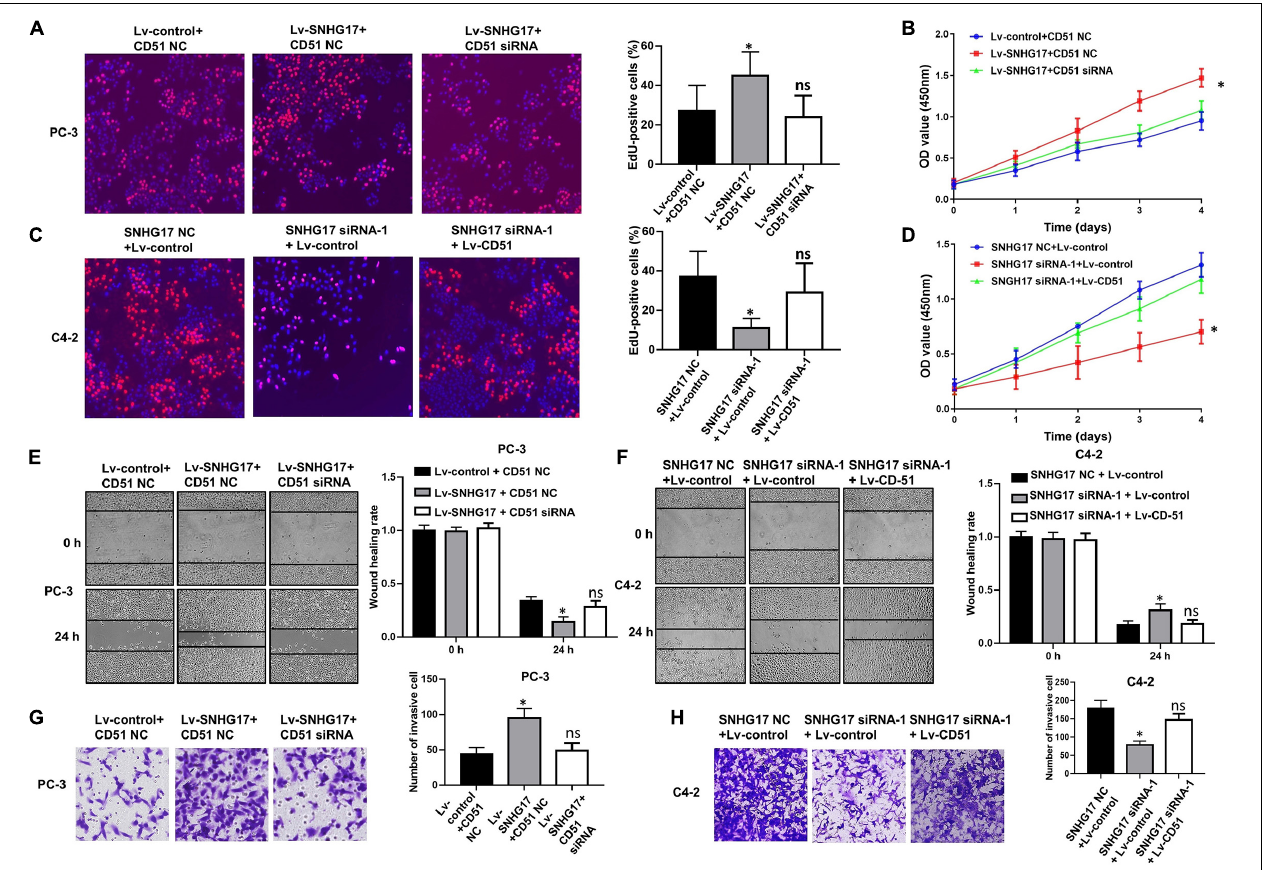
FIGURE 5 | CD51 is involved in SNHG17-mediated CRPC cell proliferation and invasion. (A) The effects of down-regulation of CD51 on SNHG17 mediated cell proliferation of PC-3 cells, as detected by EdU assay; (B) The effects of down-regulation of CD51 on SNHG17 mediated cell proliferation of PC-3 cells, as detected by CCK-8 assay; (C) The effects of up-regulation of CD51 on SNHG17 mediated proliferation of C4-2 cells, as detected by EdU assay; (D) The effects of up-regulation of CD51 on SNHG17 mediated cell proliferation of C4-2 cells, as detected by CCK-8 assay; (E) The effects of down-regulation of CD51 on SNHG17 mediated migration of PC-3 cells, as detected by the wound healing assay; (F) The effects of up-regulation of CD51 on SNHG17 mediated migration of C4-2 cells, as detected by the wound healing assay; (G) The effects of down-regulation of CD51 on SNHG17 mediated cell invasion in PC-3 cells, as detected by the transwell assay; (H) The effects of up-regulation of CD51 on SNHG17 mediated cell invasion in C4-2 cells, as detected by the transwell assay; Data are expressed as the mean ± S.E . * P < 0.05, ns, not significant. The representative results of three independent experiments are shown.